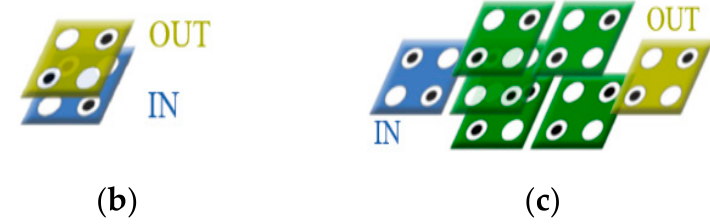
Figure 3. Multi-layer structures: ( a ) diagonal line; ( b ) vertical line; and ( c ) multi-layer robust inverter. Table 1. Performance comparison of coplanar inverter and multi-layer inverter.